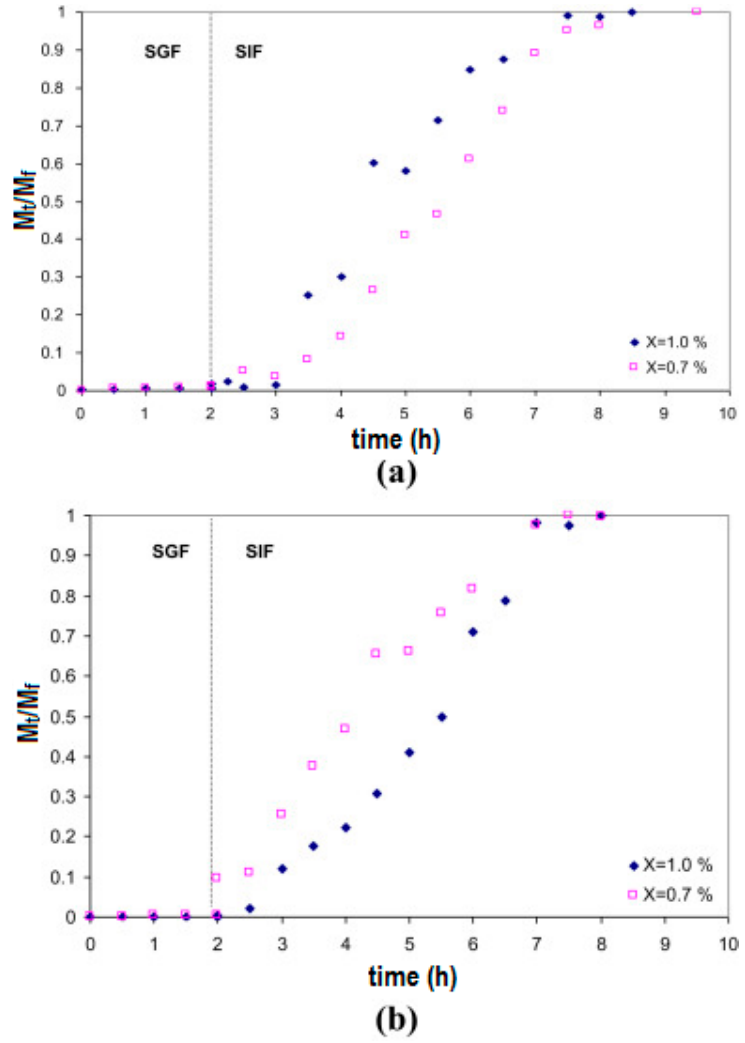
Figure 4. Fractional release of P. acidilactici from xanthan–chitosan capsules prepared under four different conditions. The release pH conditions are pH = 2.0 for SGF and pH = 6.8 for SIF. ( a ) Chitosan: 0.7% ( w / v ), pH = 6.2; Xanthan: 0.7% ( w / v ) and 1.0% ( w / v ); ( b ) Chitosan: 0.7% ( w / v ), pH = 4.5; Xanthan: 0.7% ( w / v ) and 1.0% ( w / v ). (Reproduced and adapted with permission from [218].)